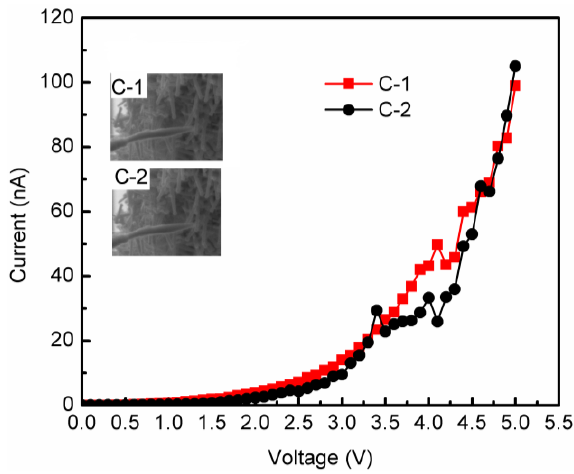
Figure 5. Current-voltage curves of a single ITO crystal rod from 0 to 5.0 V. (C-1 and C-2 are the any two nanorods of ITO).